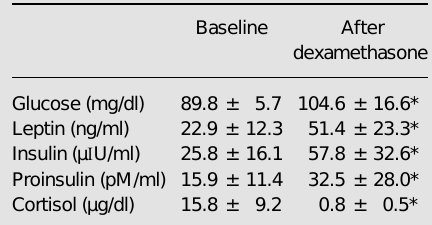
Table 2 - Serum glucose, leptin, insulin, proinsulin and cortisol levels before and after dexametha- sone administration to obese